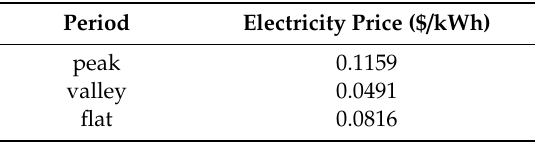
Table 3. Time of use